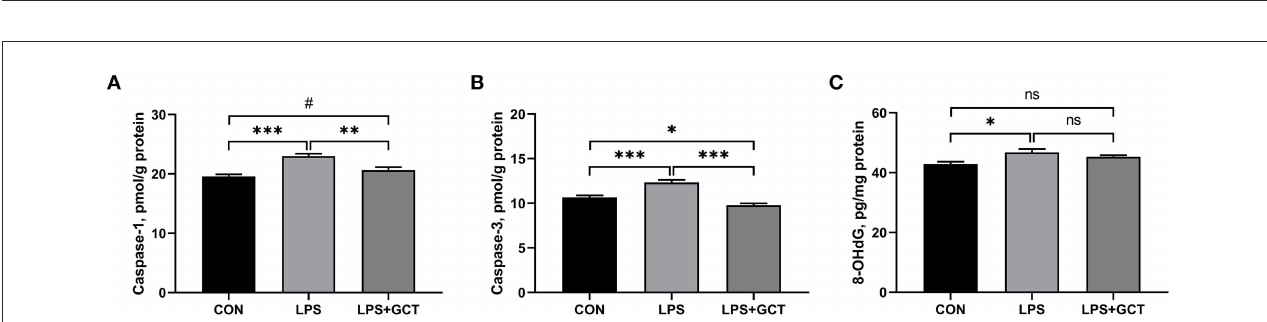
FIGURE6 Effects of dietary Galla Chinensis tannin (GCT) supplementation on hepatic caspases levels of broilers under lipopolysaccharide (LPS)-challenge. (A) Caspase-1; (B) Caspase-3; (C) 8-hydroxy-2-deoxyguanosine (8-OHdG). CON, fed on a basal diet and intraperitoneally injected with saline solution; LPS, fed on a basal diet and intraperitoneally injected with LPS; LPS + GCT, fed on a basal diet supplemented with 300 mg/kg GCT and intraperitoneally injected with LPS. Values are presented as mean ± standard error ( n = 6). * p < 0.05, ** p < 0.01, *** p < 0.001, # 0.05 < p < 0.10; ns,